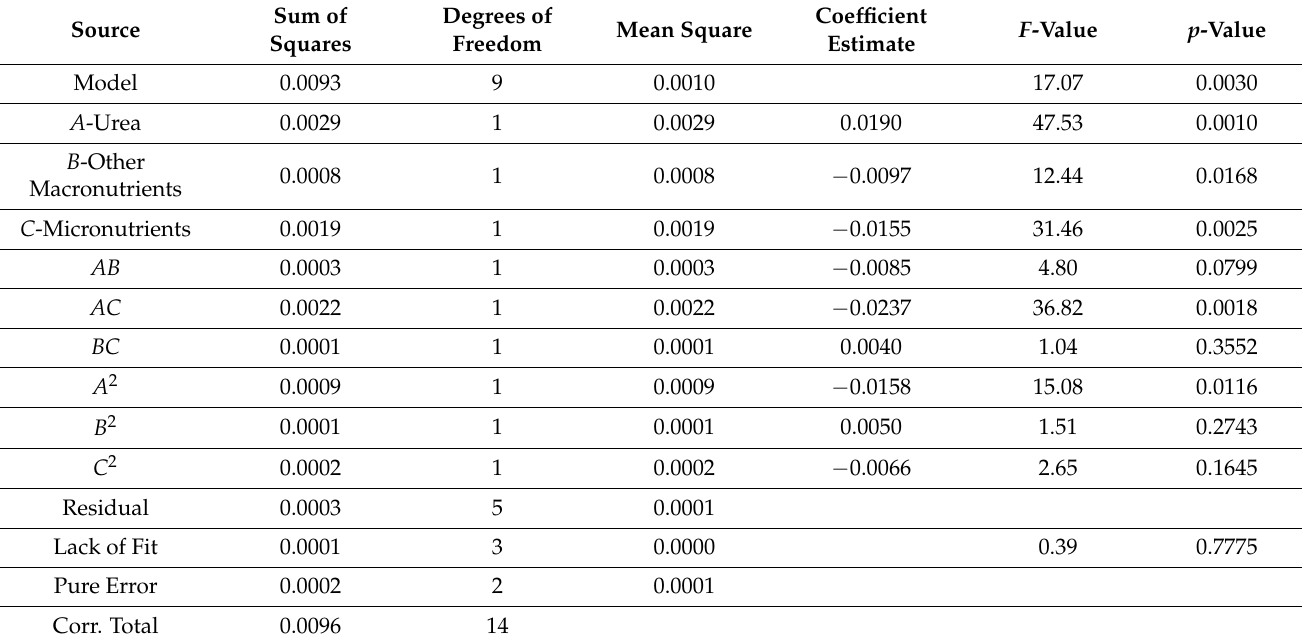
Table 6. Statistical analysis of Box–Behnken experiment for specific growth rates of photoautotrophic